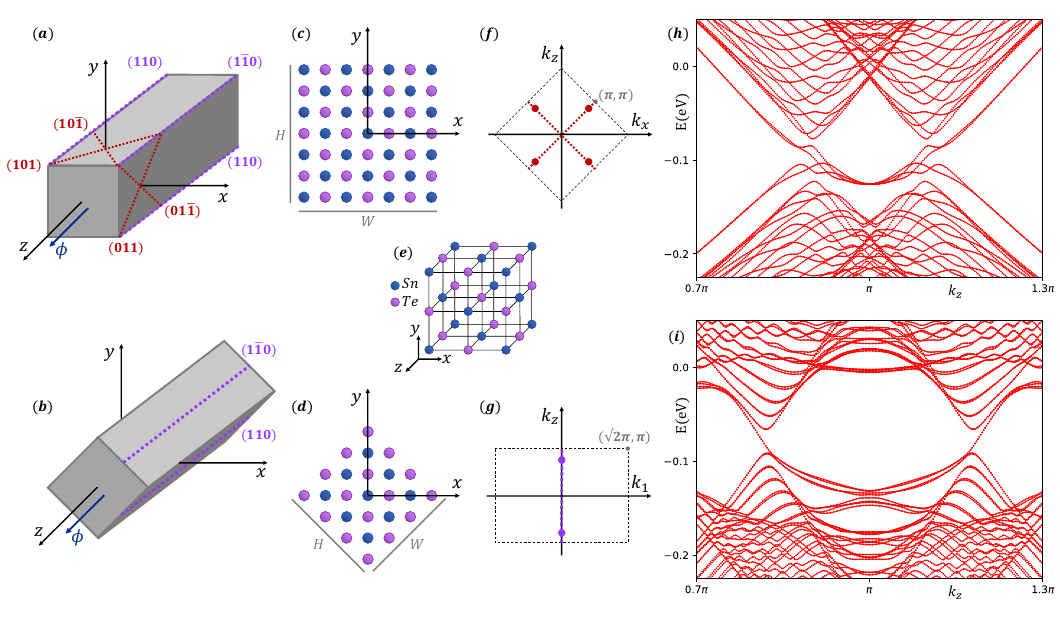
Figure 1: Suggested configurations for a SnTe nanowire: (a) the ( 100 ) wire, and (b) the ( 110 ) wire. The non-trivial mirror symmetries of the surfaces and hinges in each wire are indicated and marked by dotted lines. A flux φ is inserted along the wire’s z -axis. (c) Cross sections of the ( 100 ) wire, shown with 7 atoms in height and 7 in width. Blue and purple dots correspond to Sn and Te atoms. (d) Cross sections of the ( 110 ) wire, shown with 4 atoms in height and 4 in width. We note that for the purpose of this calculation, the wire’s cross section was chosen such the outermost layers are always the one atom longer, so that the hinges are a sharp step without a missing atom. For example, in order to make the 4x4 ( 110 ) wire depicted in Fig. 1(d) into a 5x4 wire, a layer of three Te atoms and four Sn atoms should be added to one of the facets. In this method, the intersection between the facets remains the same for all wire sizes. (e) The bulk’s crystal structure. Surface BZs and the existing Dirac cones of (f) a plane in the [ 010 ] direction, with four Dirac cones on the lines invariant under ( 101 ) and ( 10¯1 ) mirror symmetries, and (g) a plane in the [ 1¯10 ] direction, with two Dirac cones on the ( 110 ) mirror invariant line. Band structures at zero flux of (h) a ( 100 ) wire with a size of 46 atoms in height and width, and of (i) a ( 110 ) wire with a size of 28 atoms in height and width. The spectra are symmetric around = π , with all bands doubly k z